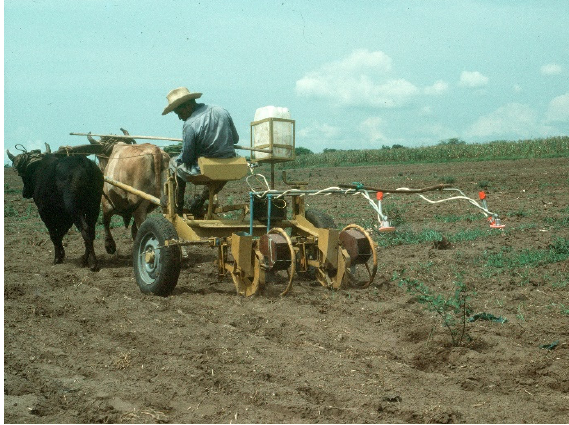
Figure 12. The development of animal ‐ drawn wheeled toolcarriers attracted considerable development effort in the 1980s; however farmer adoption was minimal.